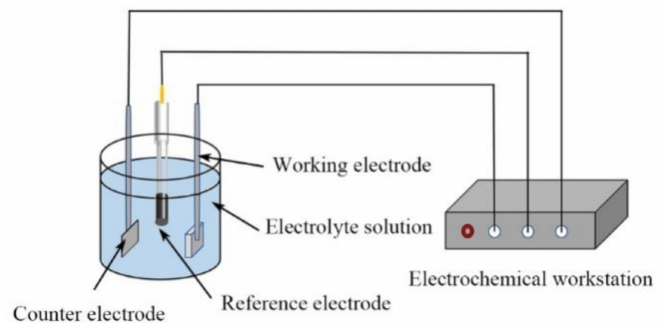
Figure 1. Schematic diagram of the electrochemical test system.